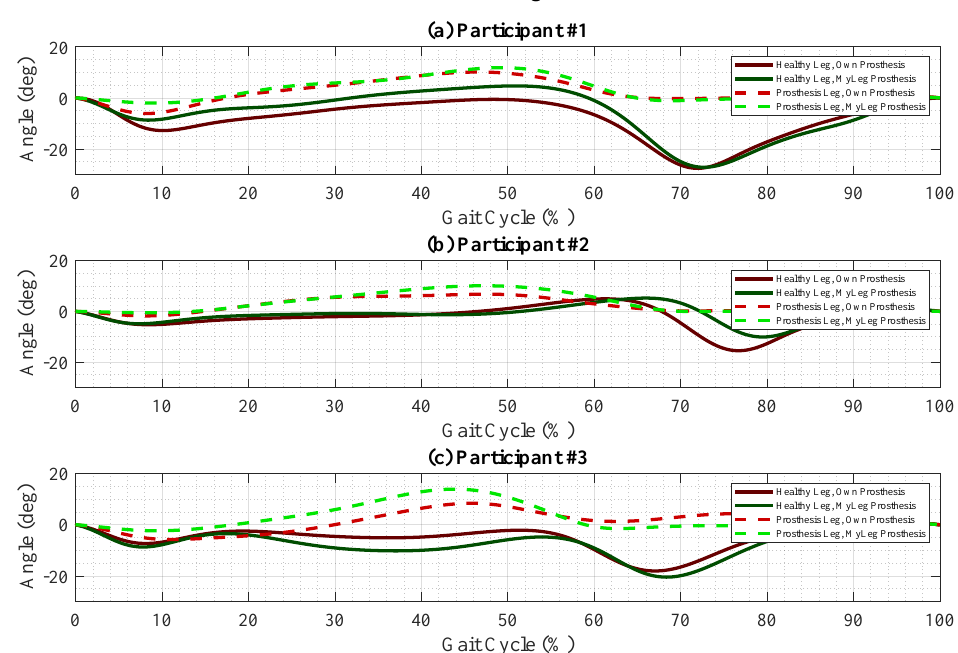
Figure 11. The ankle dorsiflexion(+) and plantarflexion( − ) during gait cycle of ( a ) Participant 1, ( b ) Participant 2 and ( c ) Participant 3: healthy leg, using their own prosthesis (dark red straight line); healthy leg, using MyFlex- δ (dark green straight line); prosthetic leg, using their own prosthesis (light red dashed line); prosthetic leg, using MyFlex- δ (light green dashed